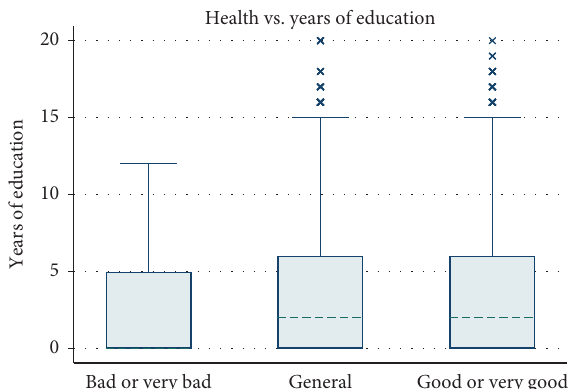
Figure 2: Years of education and self-rated health status.